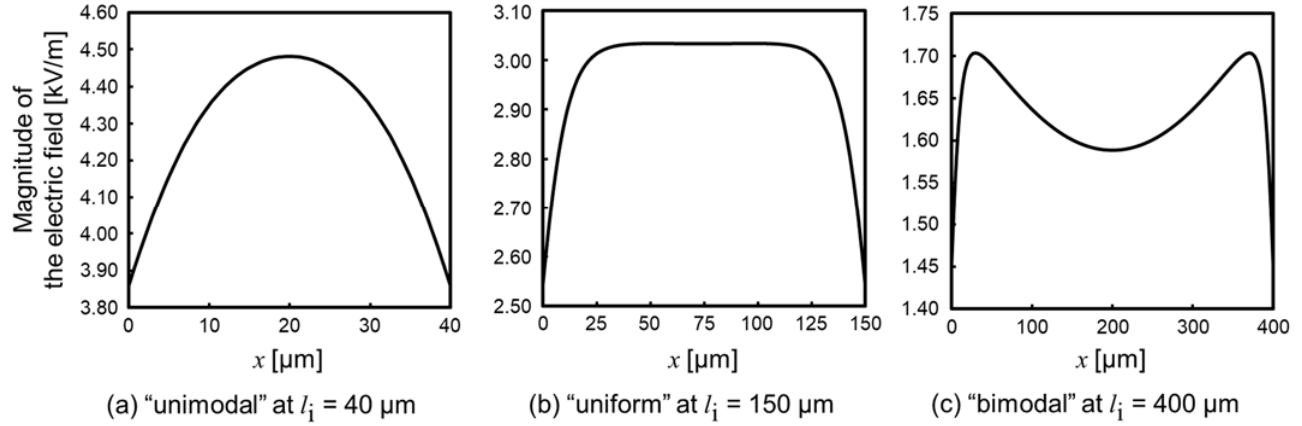
Figure 3. Generated electric field properties between the centerline and parallel insulators of the device. ( a ) The “unimodal” electric field at l i = 40 µm. The distribution has one maximal point of the electric field. ( b ) The “uniform” electric field at l i = 150 µm. The distribution partly has a uniform electric field. ( c ) The “bimodal” electric field at l i = 400 µm. The distribution has two maximal points of the electric field.